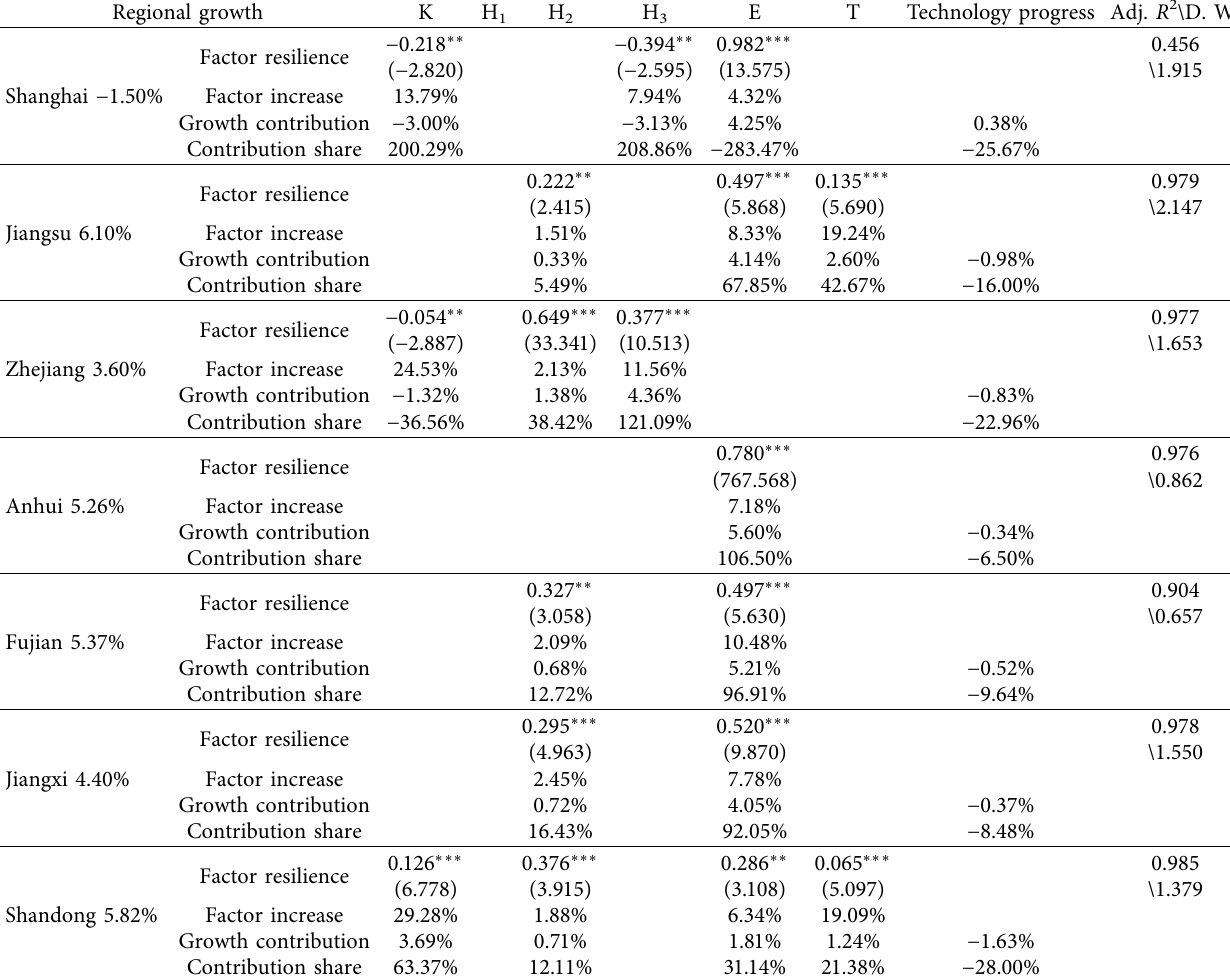
Table 1: Output elasticity of primary